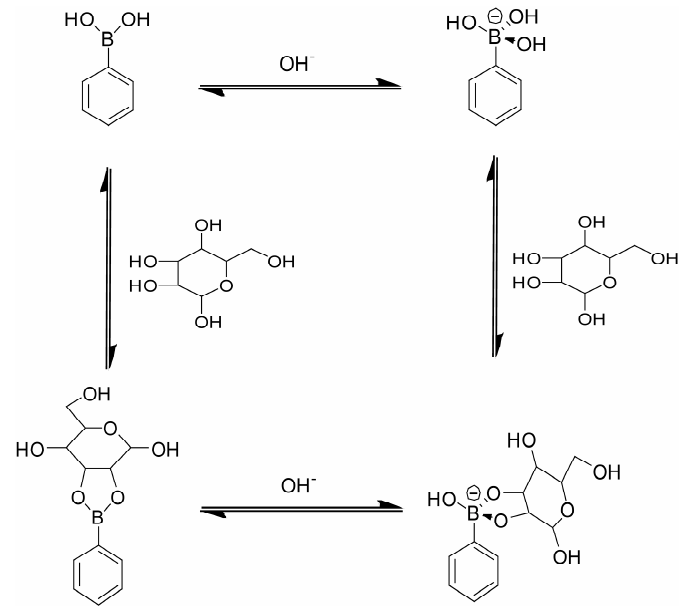
Figure 2. Binding equilibria of PBA with